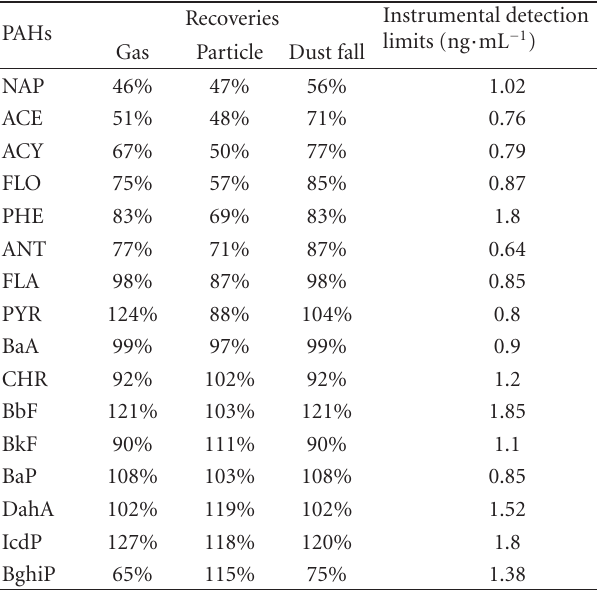
Table 1: Recoveries and instrumental detection